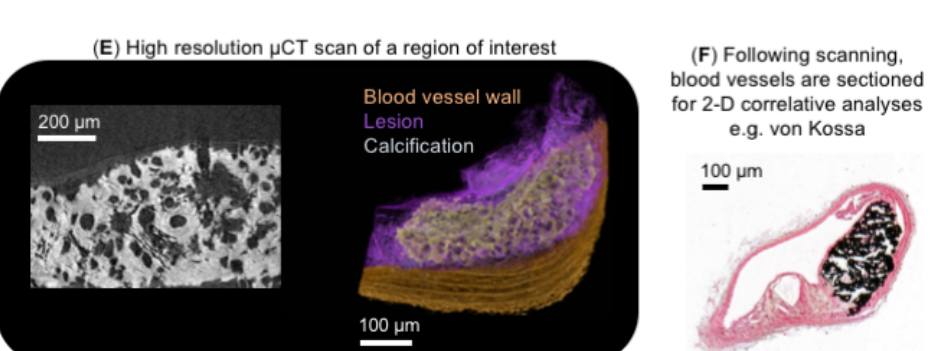
Figure 4. Correlative imaging of ex vivo blood vessels. ( A , B ) Blood vessels dissected from mouse models of arterial calcification are fixed in 10% ( v / v ) neutral bu ff ered formalin at 4 ◦ C overnight. Tissues are dehydrated and para ffi n wax-embedded using standard histological techniques. Para ffi n blocks are then manually trimmed of embedding surplus to improve spatial resolution and reduce edge di ff raction artefacts [91]. ( C ) Blood vessels are imaged on a laboratory µ CT system; in this example, a Carl Zeiss XRM Versa-510 was used. A schematic illustration of the main components of the µ CT system is shown. ( D ) A low-resolution µ CT scan of the complete artery cross-section is performed to generate a 3-D reconstruction (achieving voxel sizes between 3 and 3.8 µ m), followed by ( E ) a higher resolution region-of-interest scan to visualize the finer structures of the calcified deposits and vascular extracellular matrix (ECM) (achieving voxel sizes between 0.50 and 0.74 µ m). X-ray dense calcification is shown in white in the phase virtual slice. In this example, images have been collected from a brachiocephalic artery taken from a 10-week old ApoE -/- PKC α -/- mouse fed a high fat, high cholesterol diet for 28 weeks to induce atherosclerosis and intimal calcification. Markers such as gold spheres could be used to locate the same region of interest across µ CT and nCT devices to analyze tissue structures across multiple length scales [70,87]. ( F ) Following µ CT scanning, blood vessels can be re-embedded in para ffi n wax and sectioned for histological (e.g., von Kossa to analyze calcification), immunohistochemical and LCM-MS approaches.